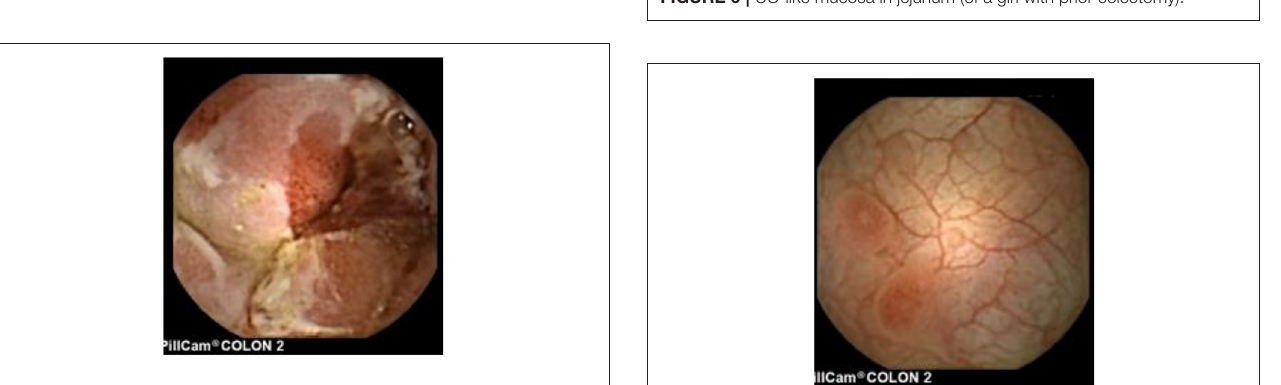
FIGURE 6 | UC-like mucosa in jejunum (of a girl with prior colectomy).